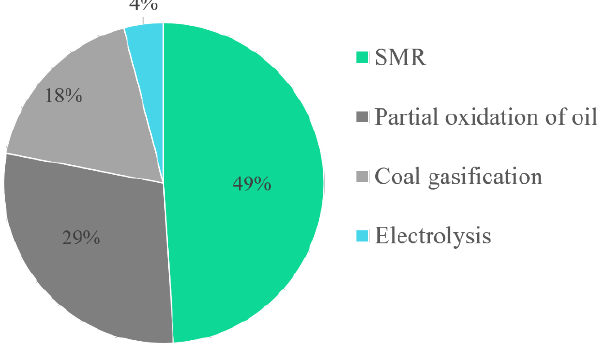
Figure 2. Share of global hydrogen production by technology [27]. Reprinted with permission by John Wiley and Sons.